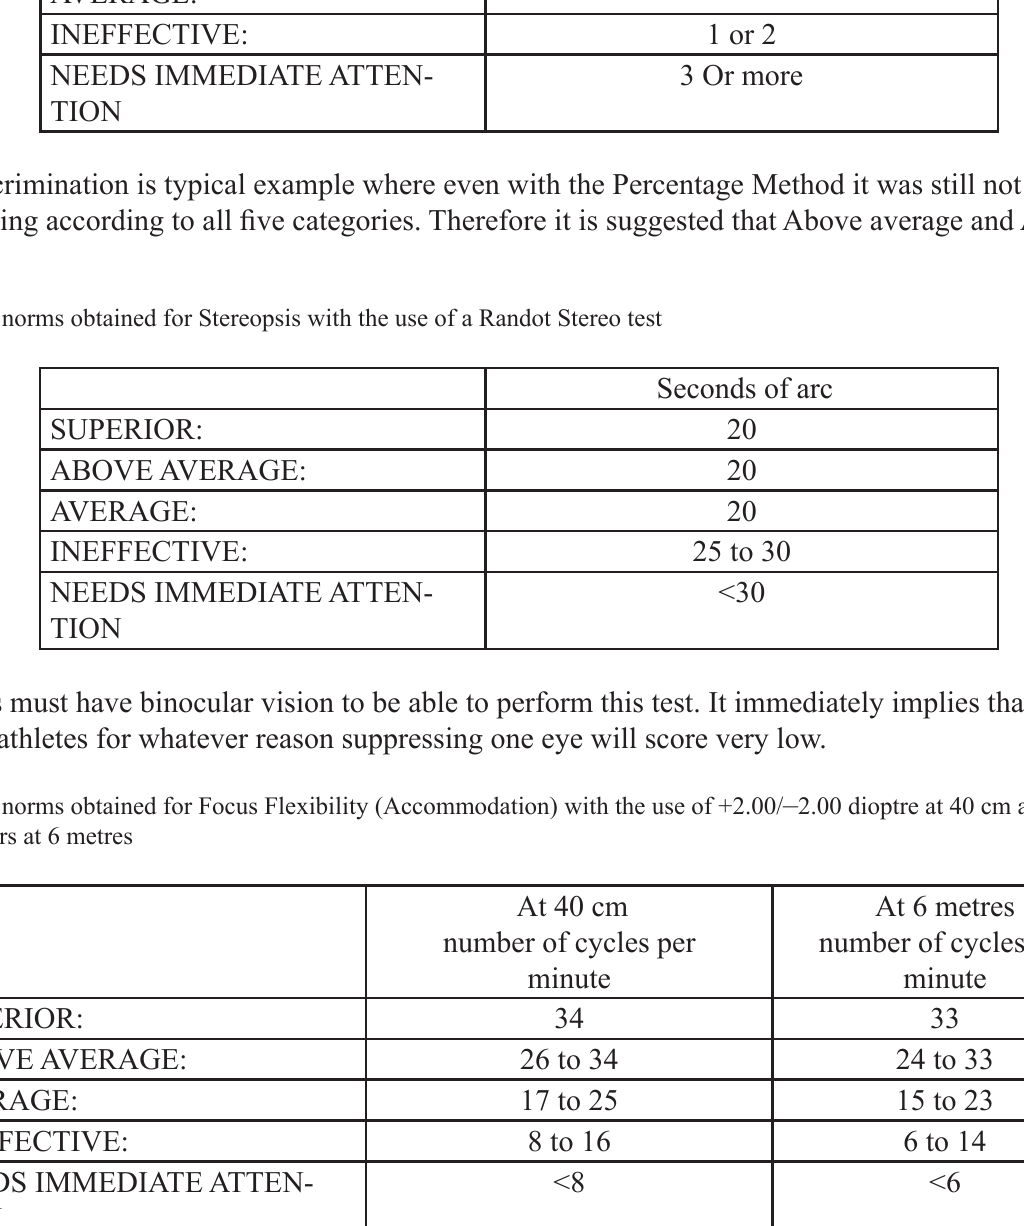
Number of errors